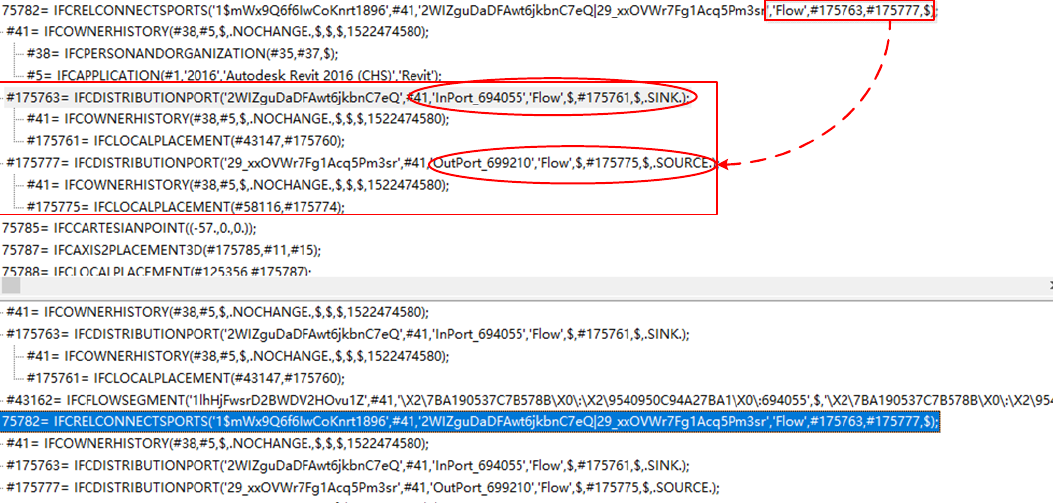
Figure 14. Example of the upstream and downstream relationship.